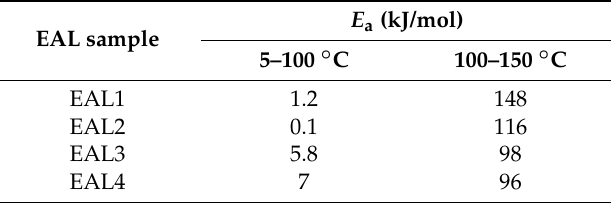
Table 4. Activation energy values for EAL-based oleogels.